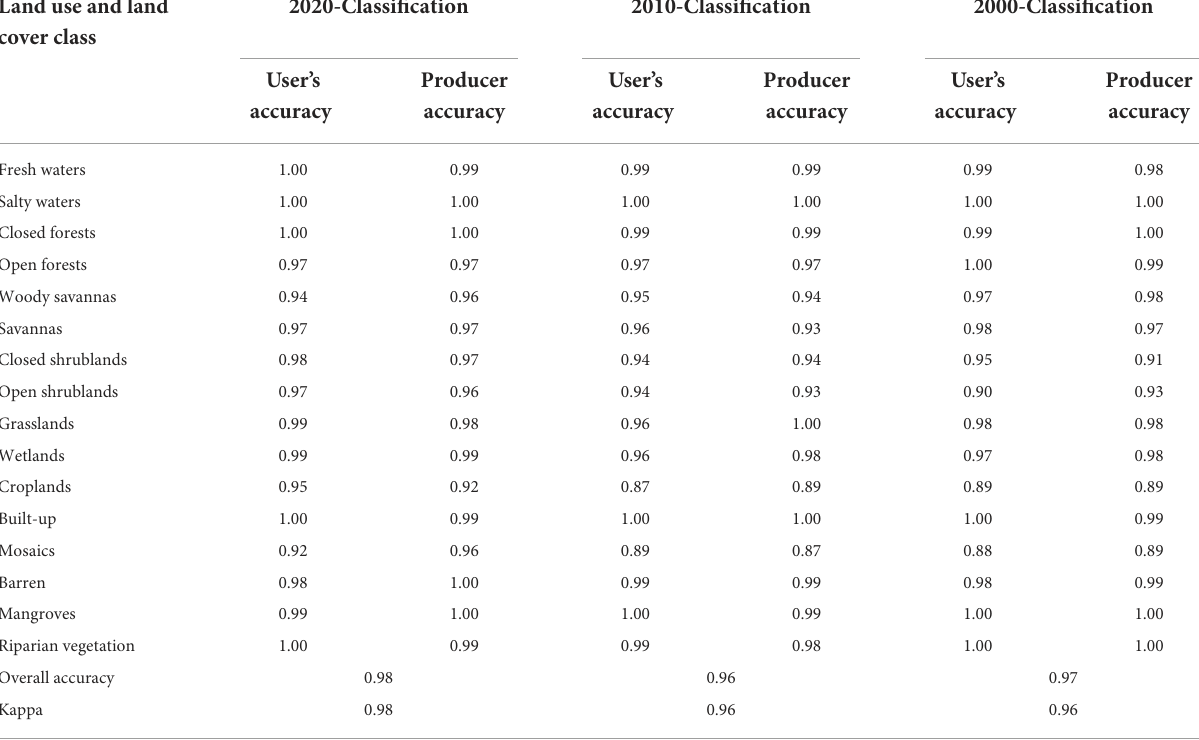
TABLE 2 Accuracy assessment of multi-temporal land use and landcover classifications used for assessing the dynamics of mangrove forests in The Gambia between the period 2000 and 2020. Land use and